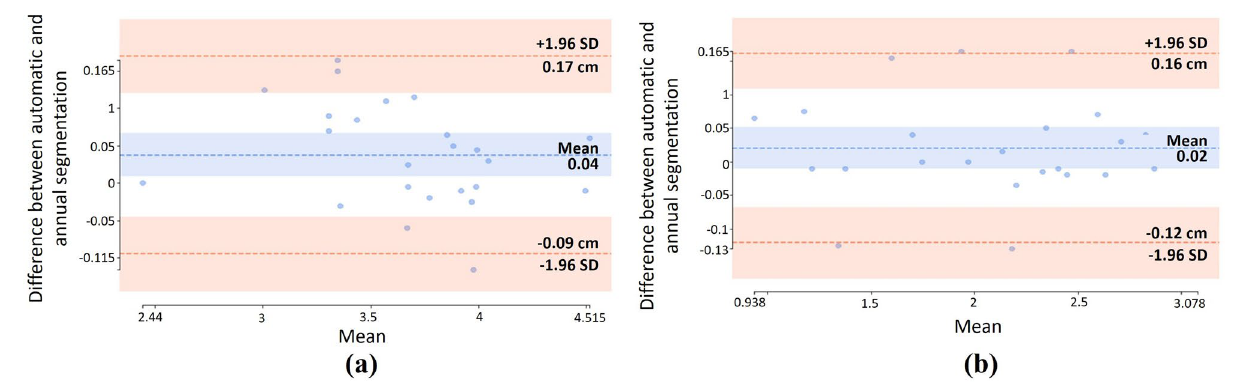
Figure 11. Bland–Altman for CRL and fetal foot length measurement in test set. CRL (a) , fetal foot (b) .